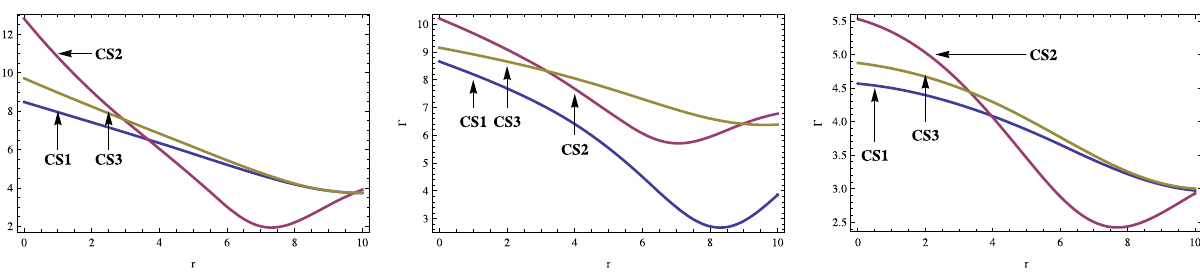
Fig. 16 Variations of | v 2 st − v 2 sr | versus r (km) with the numerical values of A , B and C from Tables 2, 3 and 4 respectively